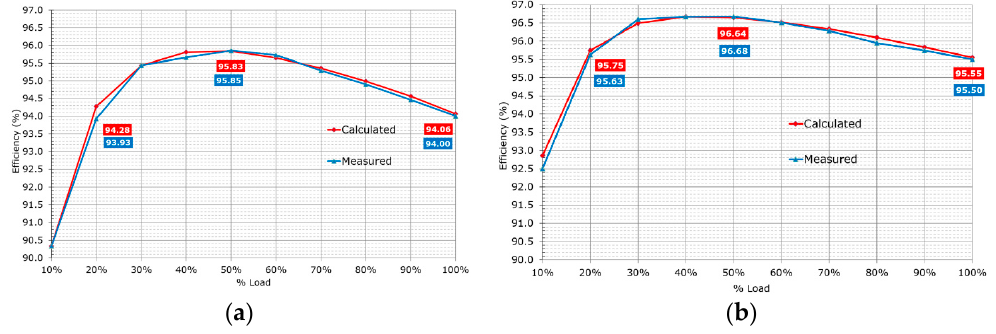
Figure 21. Overall efficiency of the converters, including fan consumption. ( a ) Original reference design. ( b ) New optimized design. Table 10. Summary of efficiency requirements for back-end power factor correction (PFC) AC-DC stage.